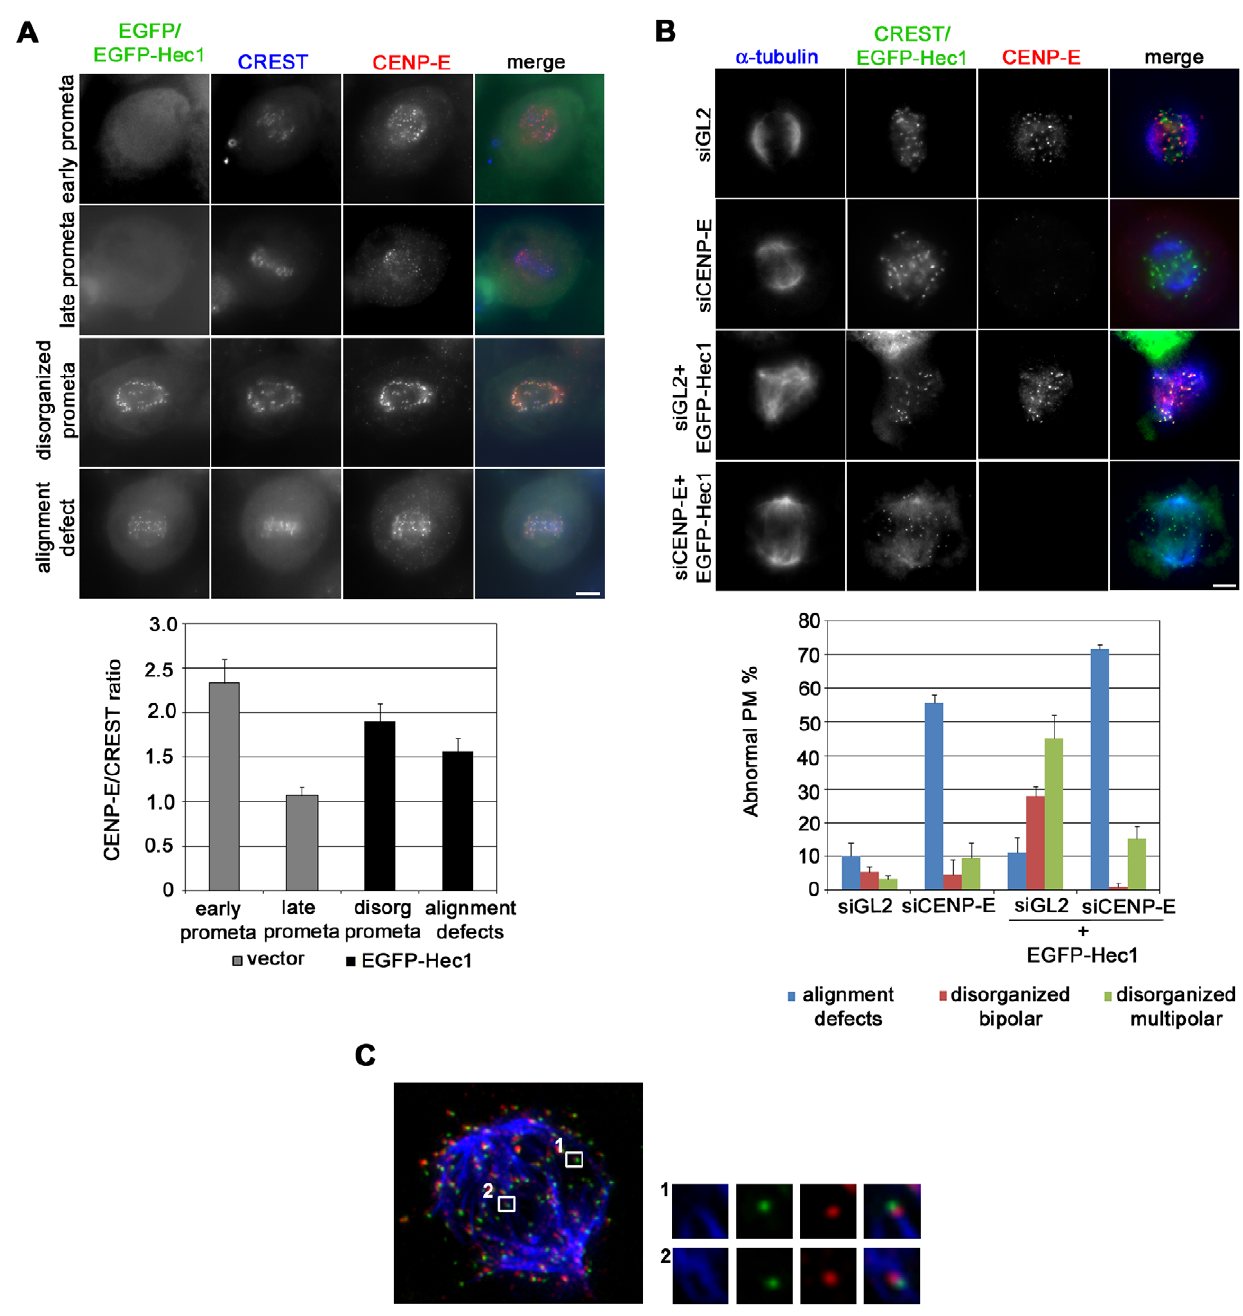
Figure 7. CENP-E function is implicated in centrosomal fragmentation. (A) Kinetochore accumulation of CENP-E (red) in an early and a late normal prometaphase from vector transfected cultures and in a disorganized prometaphase and a late prometaphase with alignment defects from EGFP-Hec1 (green) trasfected cultures. Kinetochores are marked by CREST staining (blue). The graph shows a quantitative analysis of CENP-E intensity at kinetochores, in vector and EGFP-Hec1 transfected cells. CENP-E/CREST ratio was significantly higher in disorganized prometaphases (P , 0.01, t- test) and in prometaphases with alignment defects (P , 0.05) from EGFP-Hec1 expressing cells than in normal late prometaphases from vector transfected cells. (B) Chromosome congression and spindle organization in control (siGL2) or CENP-E silenced (siCENP-E) mitoses or mitoses expressing EGFP-Hec1 after control silencing (siGL2 + EGFP-Hec1) or CENP-E silencing (siCENP-E + EGFP-Hec1). Mitoses were observed after a -tubulin (blue) and CENP-E (red) staining. Kinetochores were identified by CREST staining in siGL2 and siCENP-E samples or by EGFP expression in induced samples (green). The graph shows the frequencies of abnormal PM in the different conditions. Data are mean 6 SE of . 150 PM scored for each condition in two experiments. Bars, 5 m m. (C) KT-MT attachments in an EGFP-Hec1 (green) expressing disorganized bipolar prometaphase exposed to MG132 for 2 h and stained for CENP-E (red) and a -tubulin (blue) after calcium buffer treatment. A maximum projection from deconvolved z-stacks is shown. Insets show a 3-fold enlargement of one optical slice from the boxed regions. An end-on attachment (inset 1) and a side-on attachment (inset 2) are shown.